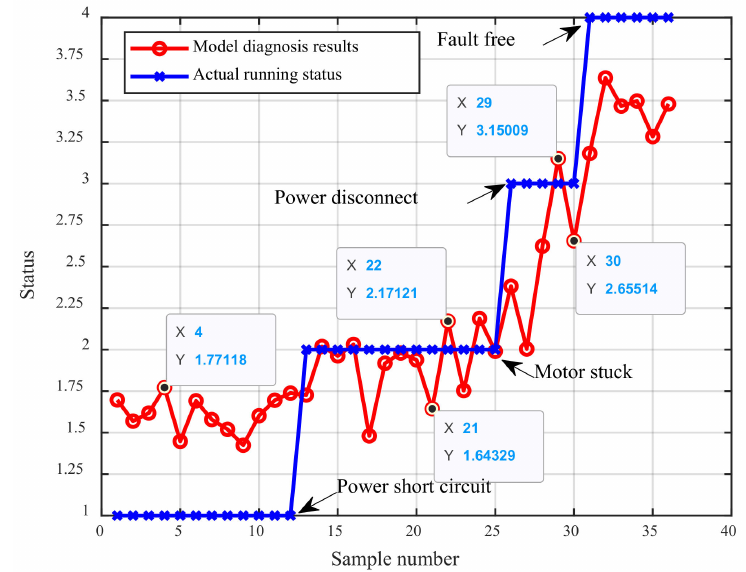
Figure 12. Fault diagnosis results of traditional